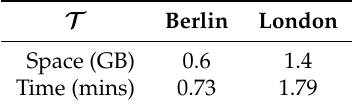
Table 4. MDTM ALT -based all-stop-pairs preprocessing time and space requirements for the Berlin and London instances with limited walking travel time.